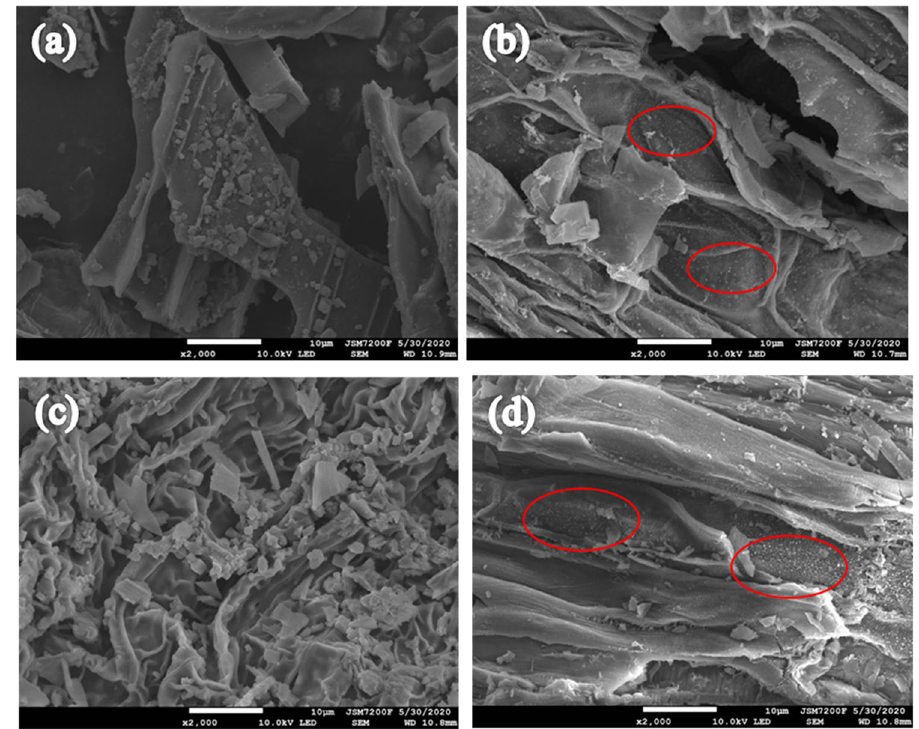
Figure 8. SEM images of ( a ) Cu-BC; ( b ) Cu-BC + Cu; ( c ) Zn-BC and ( d ) Zn-BC +